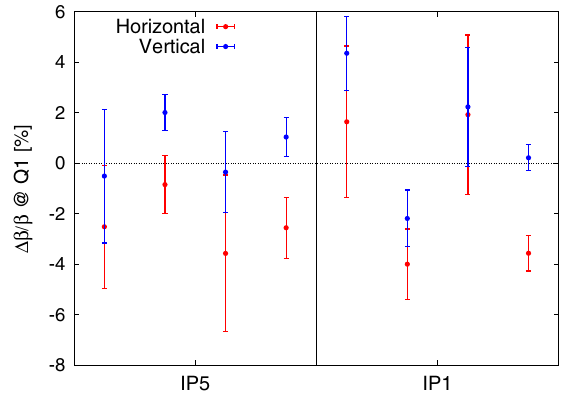
FIG. 10. (cid:1) beating from K modulation at the first quadrupoles by IP1 and